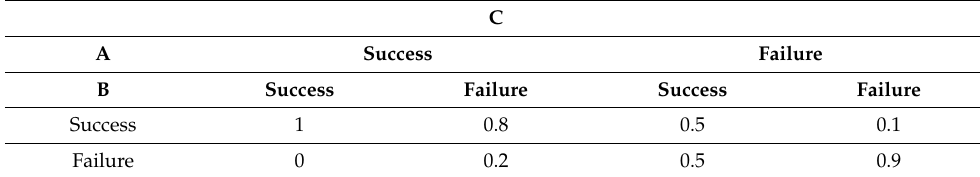
Table 1. A sample of the CPT related to Figure 1.